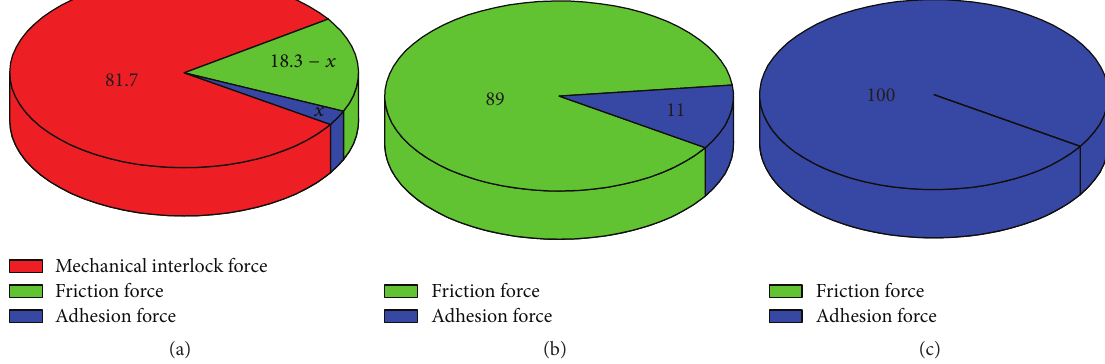
Figure 8: Constitution of bond strength: (a) deformed bar, (b) plain bar, and (c) plain